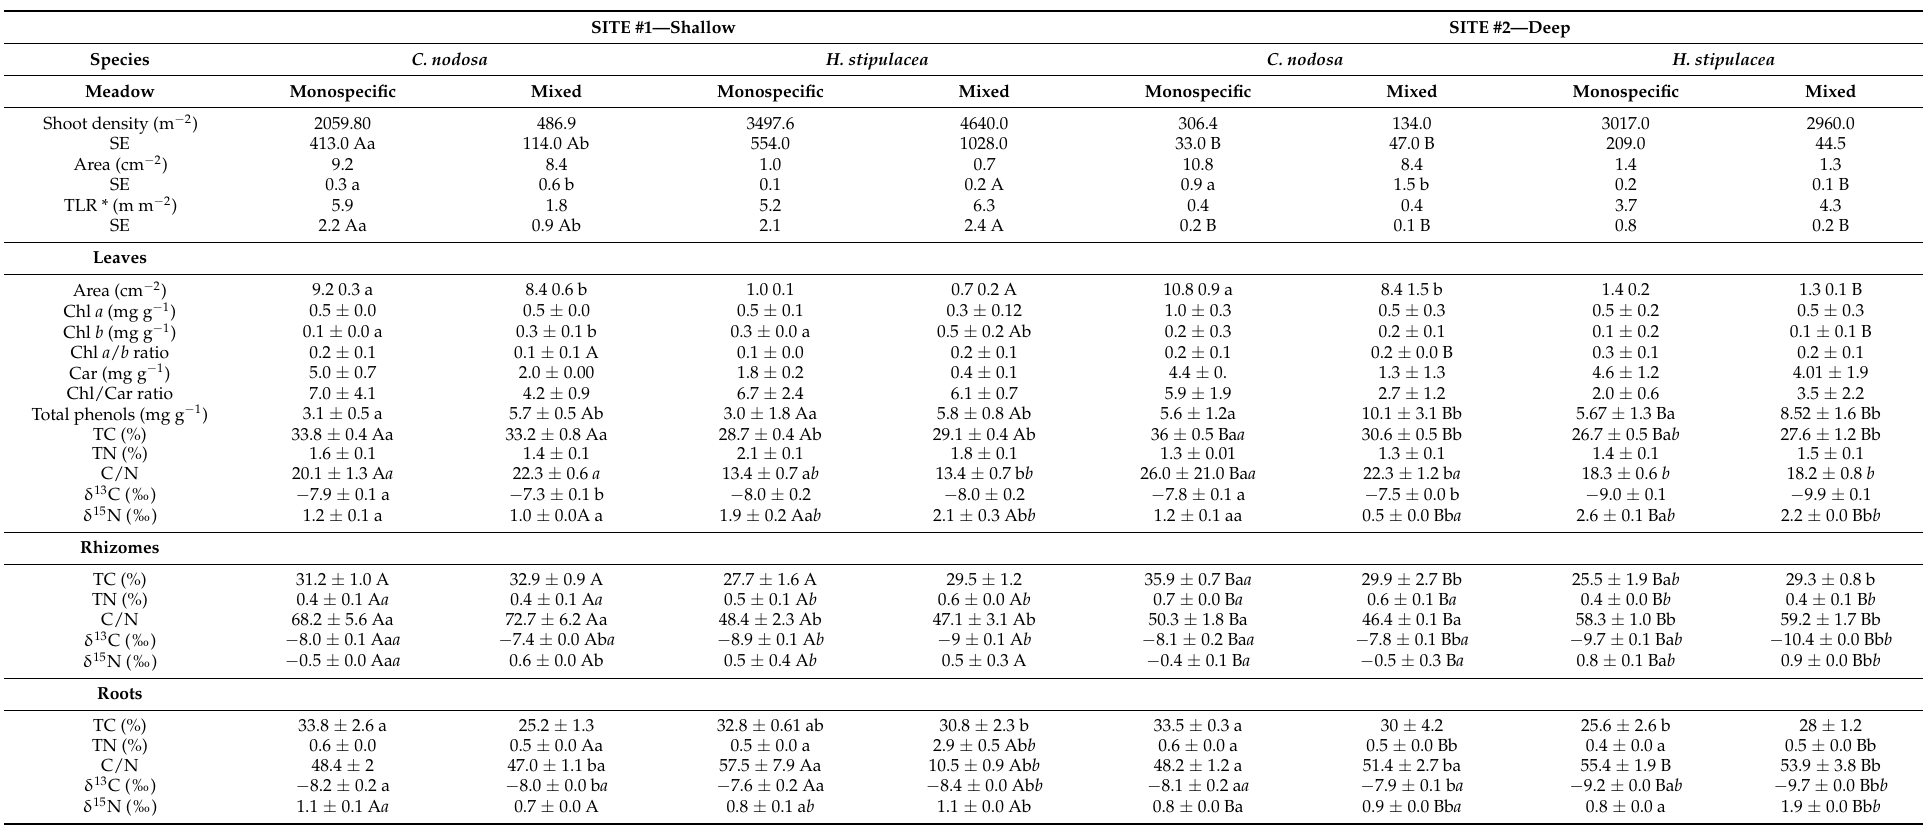
Table 3. Characterization of biotic descriptors (mean values ± standard deviation for biochemical data). Significant differences between sites (two-way ANOVA and Tukey’s pairwise post-hoc test) are indicated in capital letters, in lowercase between meadow zones, and in italics lowercase letter between